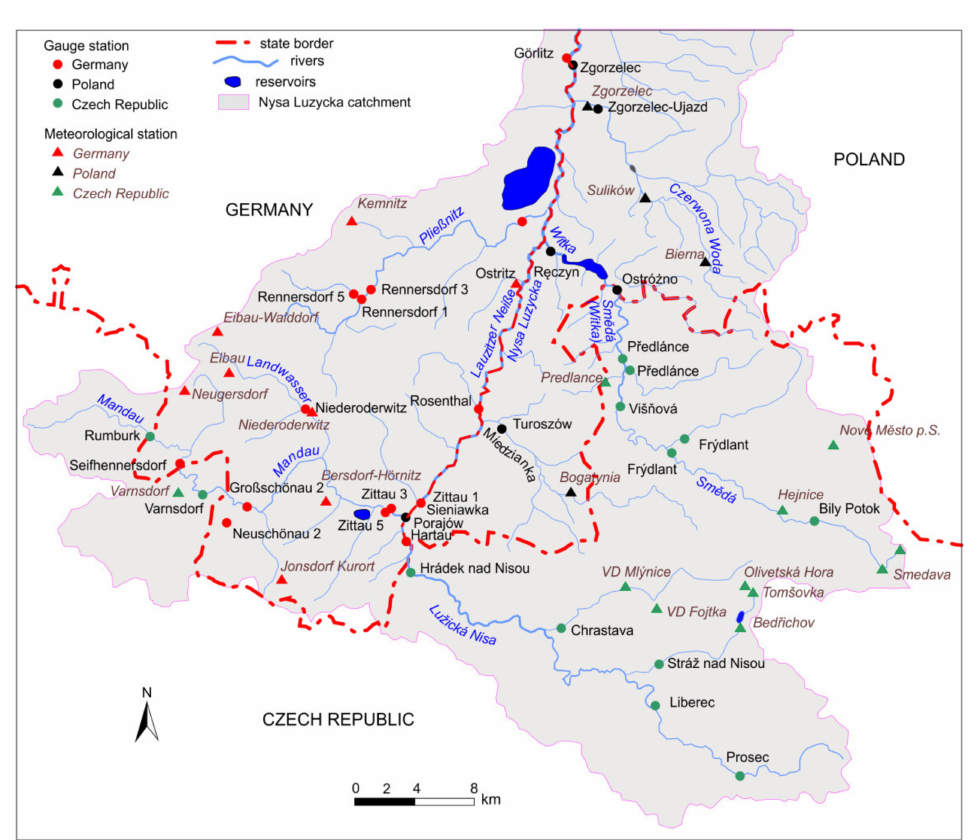
Figure 6. The upper Lusatian Neisse catchment area up to the Görlitz (GE)/Zgorzelec (PL) gauge